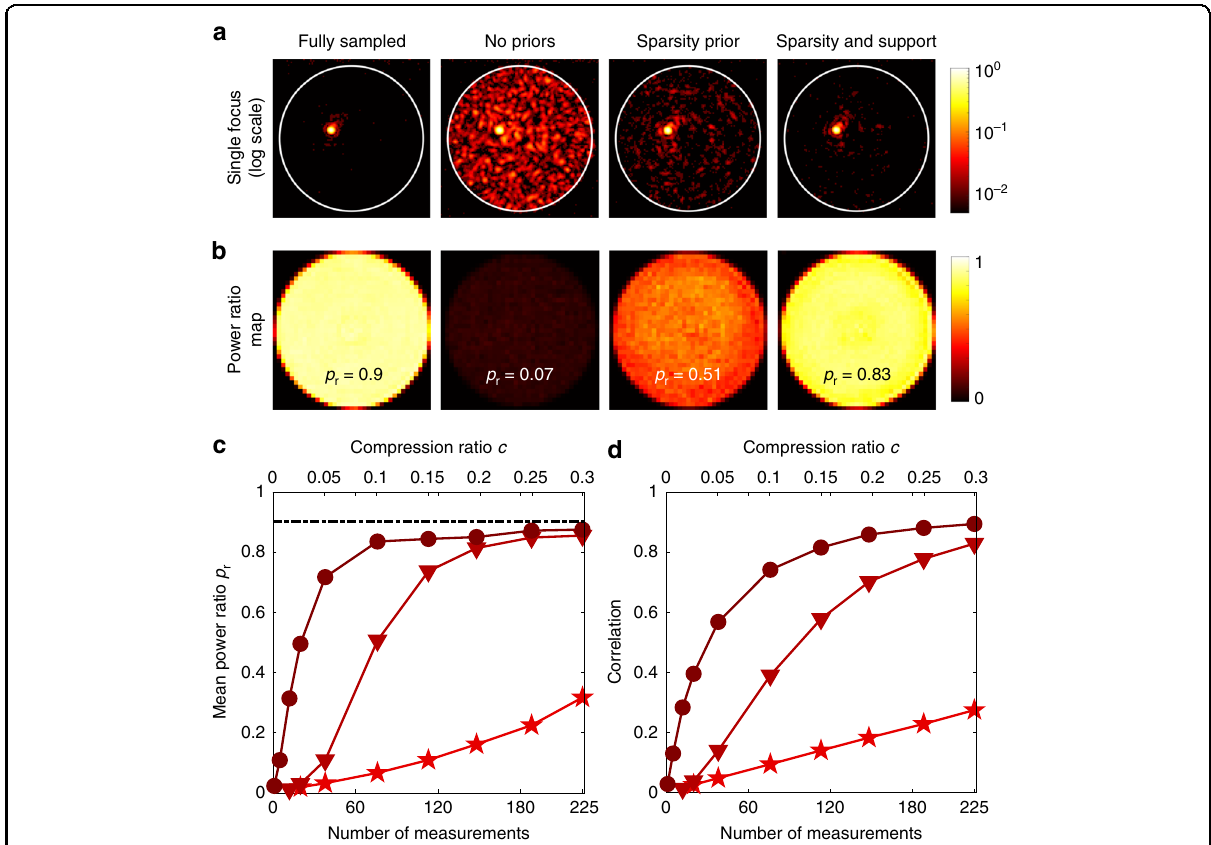
Fig. 2 Compressively sampled TM fi delity. a Examples of output foci created using TMs reconstructed in different ways at a compression ratio of c = 0.1. b Corresponding power-ratio maps of the spots generated with each reconstruction strategy. c Graph showing how the mean power-ratio p r varies as a function of c and the number of measurements, m , for three different reconstruction strategies incorporating different levels of prior knowledge. The black dash-dotted line corresponds to p r = 0.9 in the fully sampled case. d Graph showing how the level of correlation between the under-sampled and fully sampled TMs varies as a function of c . Key for graphs ( c , d ): stars = no priors; triangles = sparsity prior; circles = sparsity